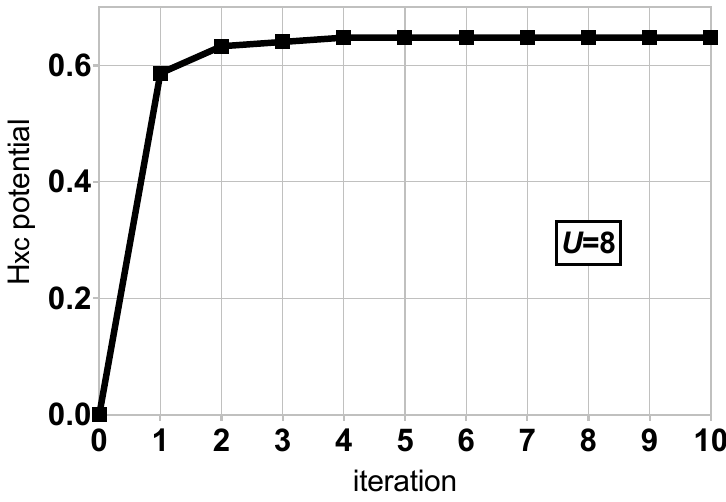
Figure 4. Convergence of the LPFET Hxc potential for U / t = 8 and µ / t = −